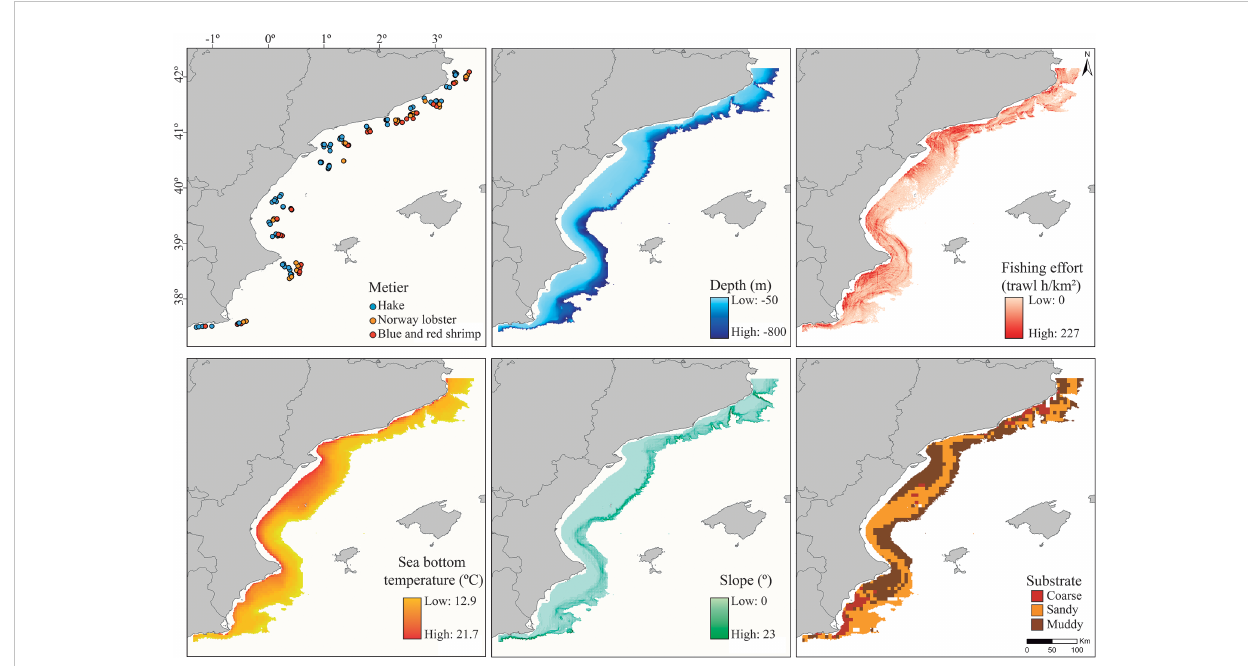
FIGURE 2 Environmental and fi shing-related drivers used as predictors to model the distribution and structure of the chondrichthyan community, including: (A) me ́ tier, (B) depth, (C) fi shing effort, (D) sea bottom temperature, (E) slope, and (F) seabed substrate. The values for each variable are spanned within the study region (GSA06) from 50 to 800 m